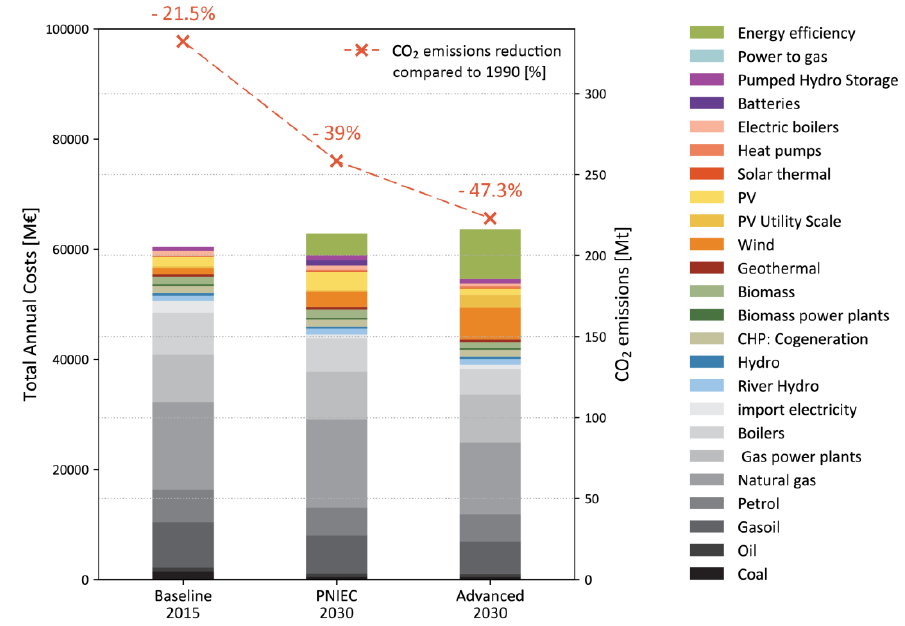
Figure 12. Total annual costs for the scenarios Baseline 2015, PNIEC 2030 and Advanced 2030.